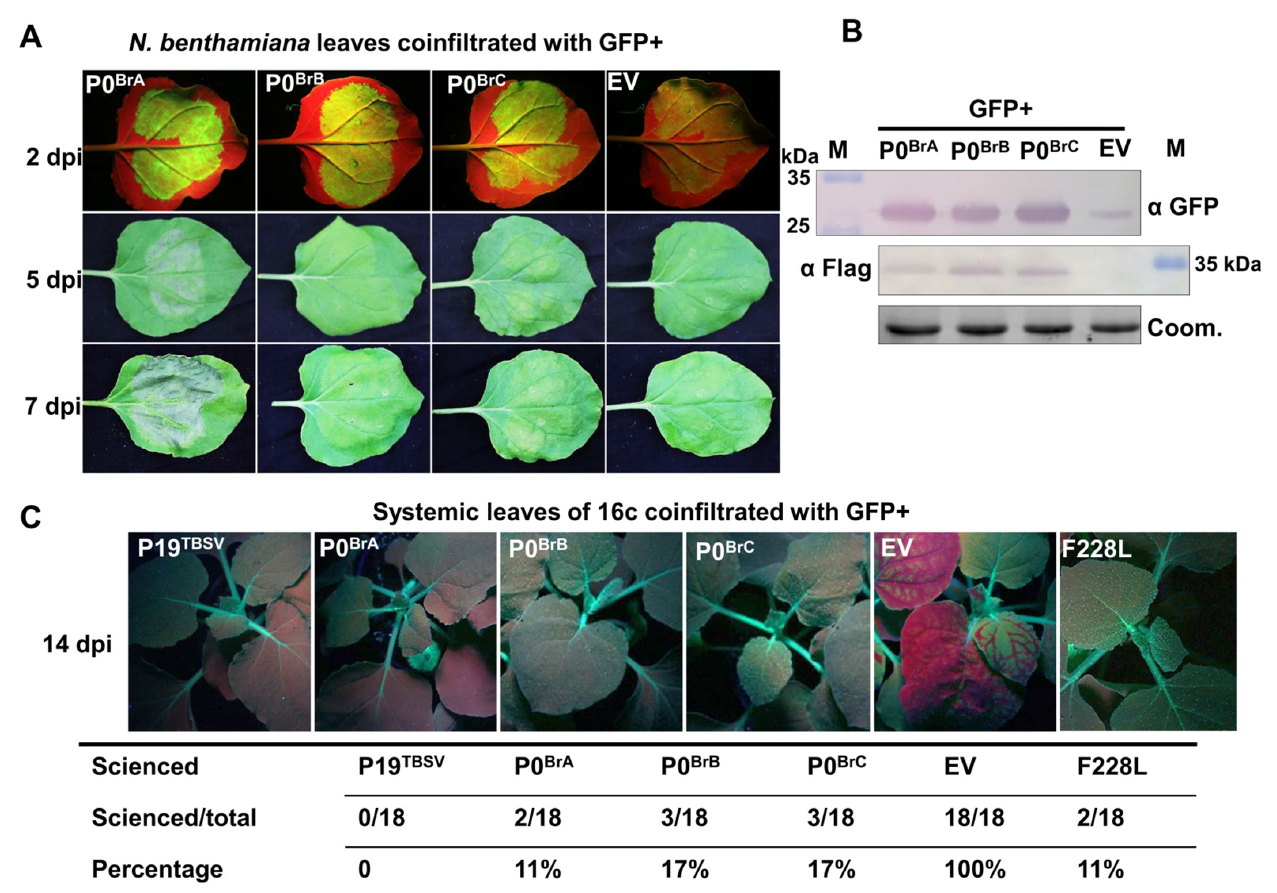
Figure 2. Suppression of local and systemic RNA silencing by P0 BrB and P0 BrC . ( A ) Suppression of local GFP silencing in N. benthamiana -infiltrated leaves. Agroinfiltration with GFP and an empty vector pGD (EV), P0 BrA , P0 BrB , or P0 BrC . The leaves infiltrated with EV were included as the negative control. ( B ) Western blot analysis of GFP and three Flag-tagged P0 Br protein levels in infiltrated N. benthamiana leaf patches using an antibody specific for GFP and Flag, respectively. Coomassie-stained (Coom.) gels are the loading control. M, molecular weights of protein marker. ( C ) Systemic RNA silencing suppression activity of P0 BrB and P0 BrC . Transiently coexpressed GFP and P0 were in leaves of N. benthamiana line 16c. P19 TBSV and EV were used as positive and negative controls, respectively. The efficiency of systemic silencing is presented below the images. The ratio shows the number of systemic silencing plants to the number of infiltrated plants, scored in three independent experiments.